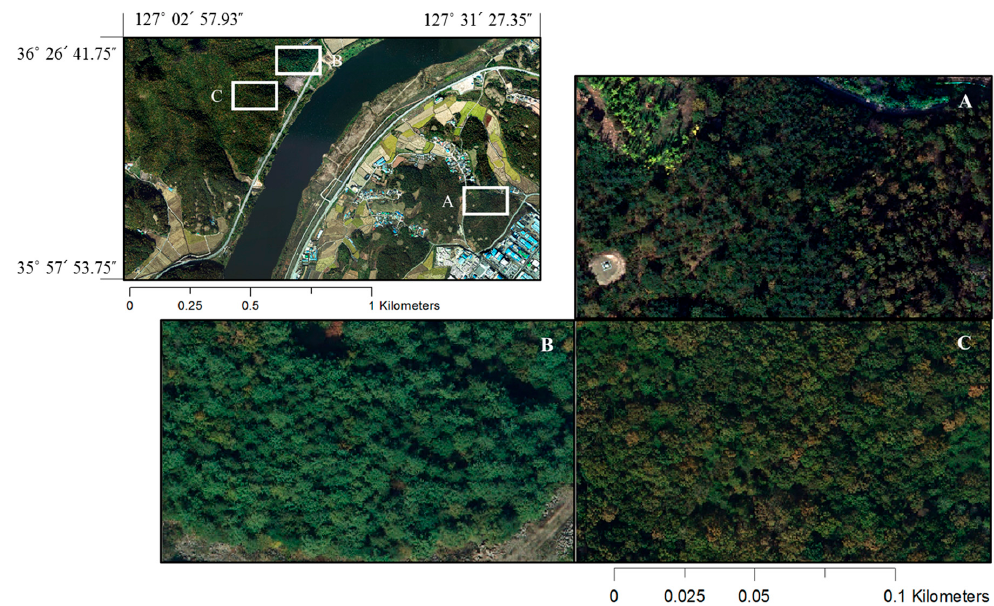
Figure 3. Example images from the study area showing the different forest vertical structures. ( A ) A single-layered forest that is a broad-leaved forest. The chestnut tree (Castanea crenata var. dulcis) is dominant; ( B ) a double-layered forest, which is a coniferous forest in which the nut pine (Pinus koraiensis) is dominant; and ( C ) a triple-layered forest that is a broad-leaved forest. The sawtooth oak (Quercus acutissima) is dominant.